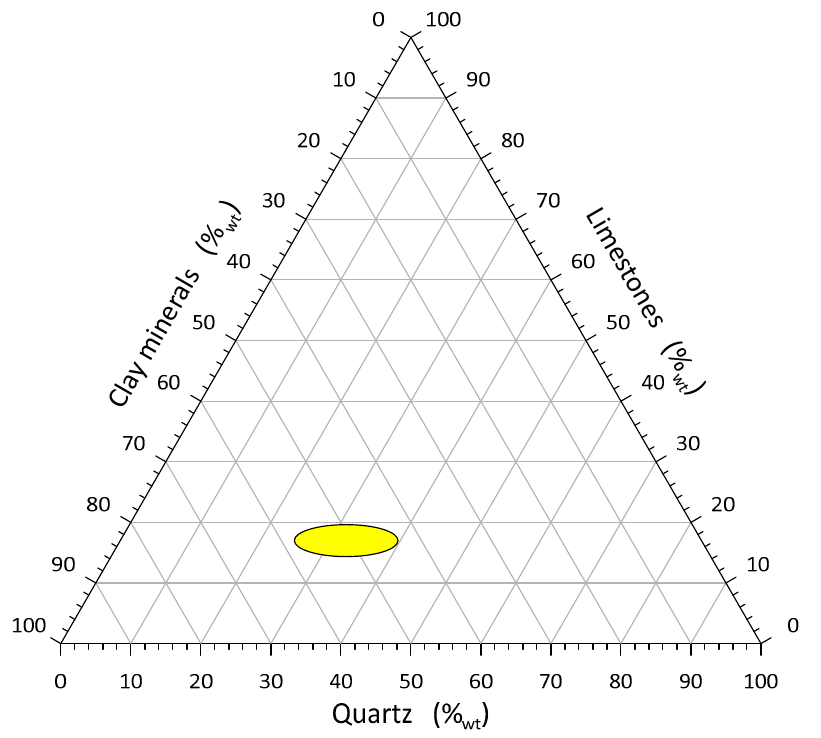
Figure 2. Diagram of typical rational compositions of ceramic masses with limestone’s.